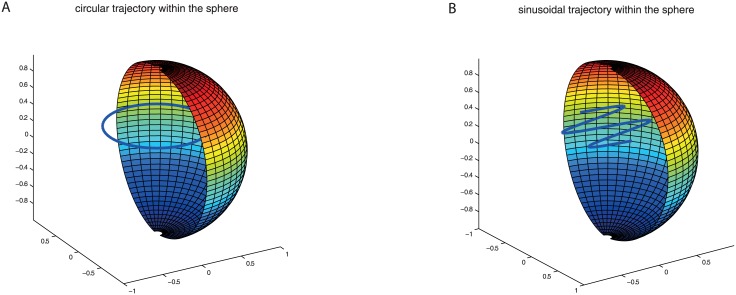

A) shows a circular trajectory to analyze the initialization phase of the adaptive MFA. The height of the trajectory lies above the middle point of the sphere to avoid trivial depth models. Due to symmetry the depth model for this configuration is the same at every trajectory point. B) shows a sinusoidal trajectory. It is used to analyze the self-motion estimation error during adaptation. Again the height of the trajectory is lifted up against the middle point of the sphere to make the depth model more complex in relation to an agent, which flies along the trajectory.